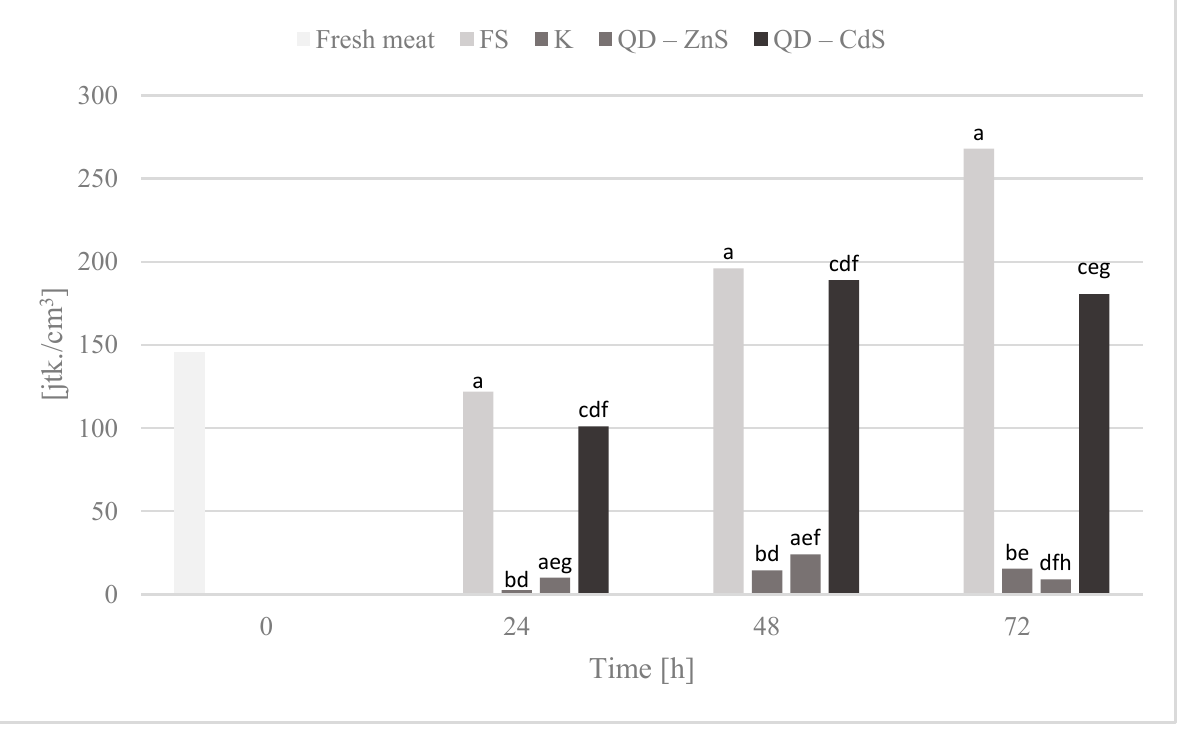
columns denoted with the same letters (a, b, c, etc.) do not differ statistically at the confidence level of p <